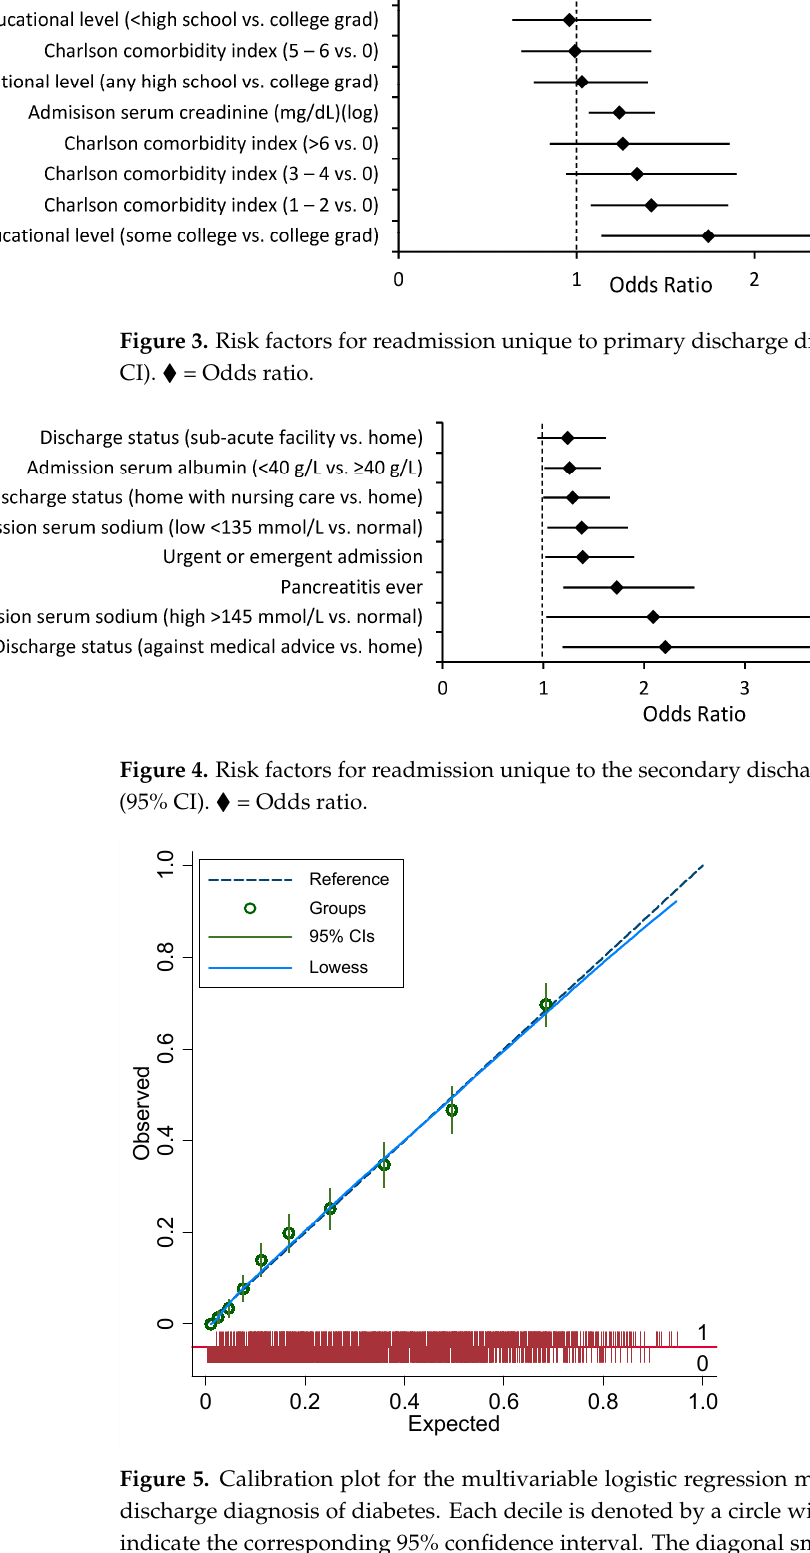
Figure 6. Calibration plot for the multivariable logistic regression model in people with secondary discharge diagnosis of diabetes. Each decile is denoted by a circle with a short intersecting line to indicate the corresponding 95% confidence interval. The diagonal smooth line (Lowess) indicates fair agreement between the observed and expected values.